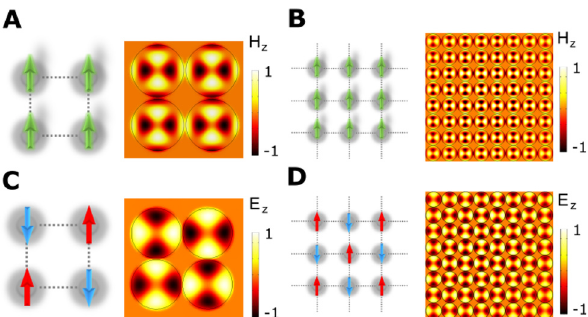
Figure 3: Ferromagnetic and antiferromagnetic XY Hamiltonians in various geometries. (A) A four-element nanodisk laser where a TE 22 mode is dominantly lasing. The corresponding ground state is ob- tained from FEM simulations. (B) Square lattice of nanodisk lasers emulating a lattice of FM coupled magnetic spins. (C), (D) Similar geometriesfornanodiskcavitieslasingina TM 21 mode,whereanAF exchangeinteractionis expectedto arise betweennearby